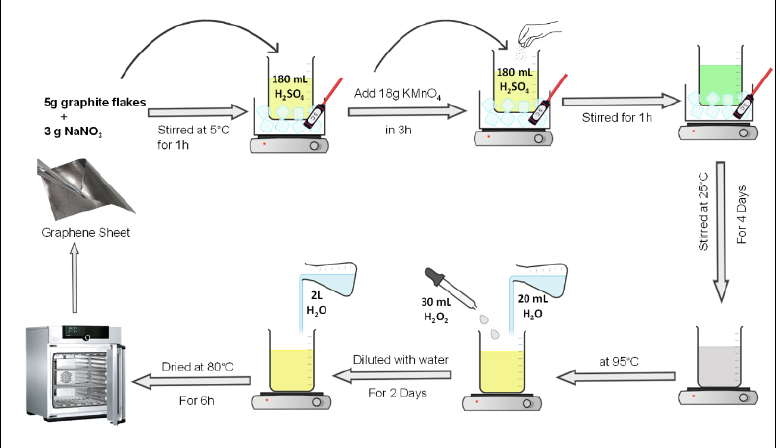
Figure 8. Schematic diagram of the synthesis of graphene using Hummer’s